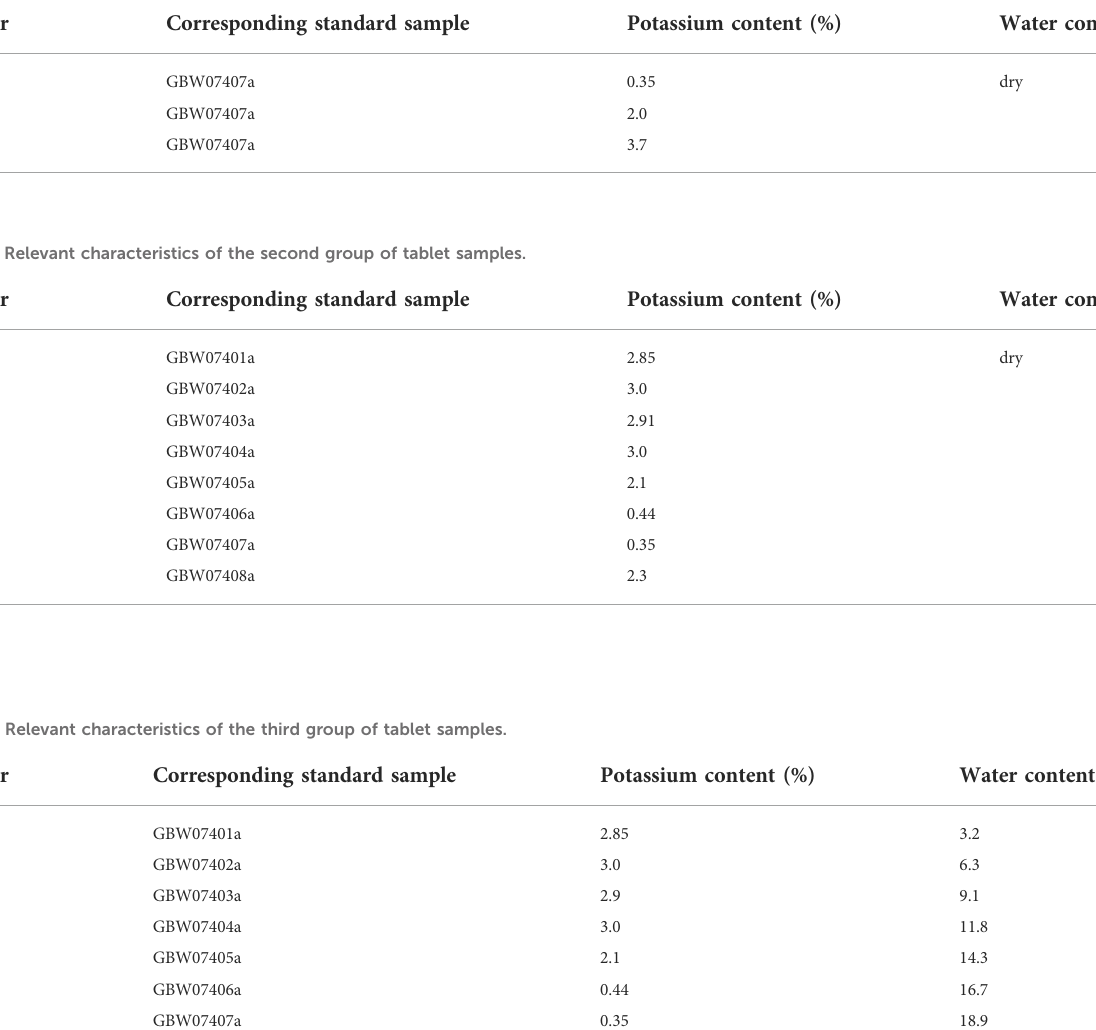
TABLE 2 Relevant characteristics of the fi rst group of tablet samples.